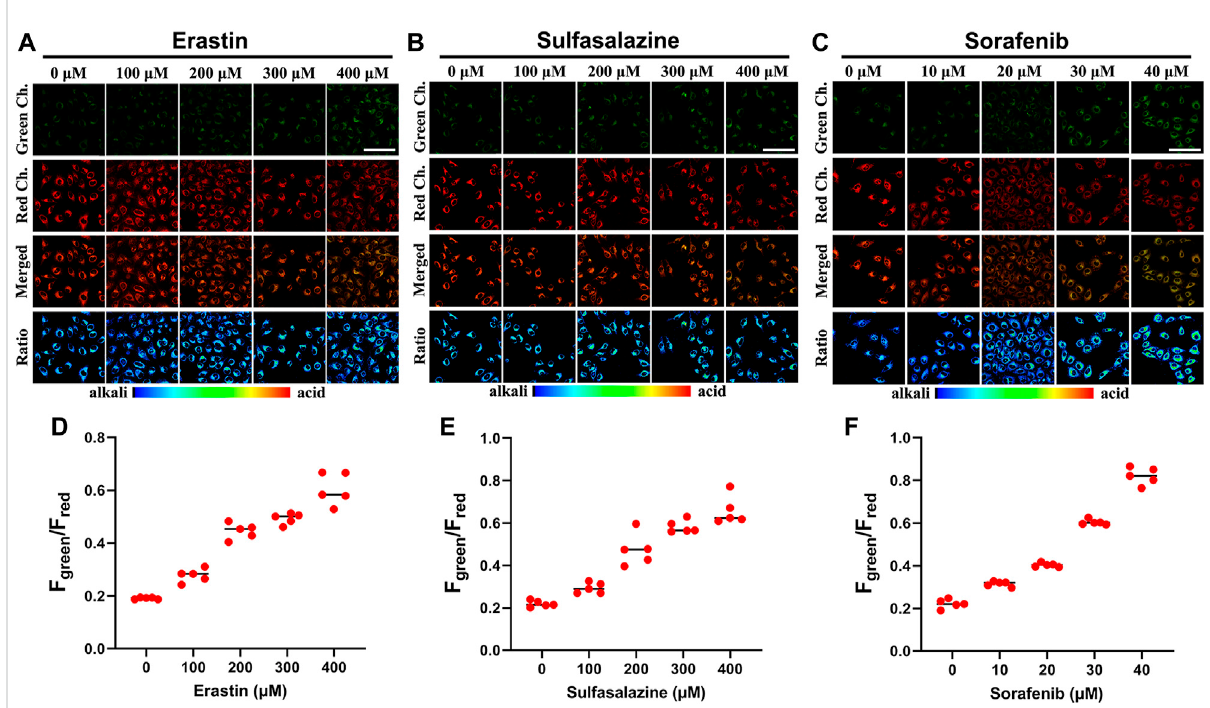
FIGURE 5 (A – C) CLSM images of Panc-1 cells incubated underdifferent drug (erastin, sulfasalazine, and sorafenib) concentrations with 5 μ MCy-Cys-pH. (D – F) The fl uorescence intensity of green/red ratio to (A – C) under pretreatment with drugs under different concentration conditions ( n = 5).